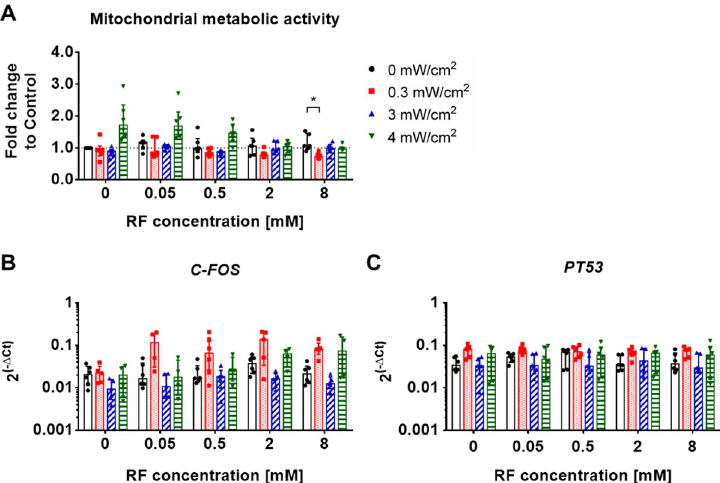
Fig 5. Viability analysis of AF cells directly after Riboflavin (RF) and UVA light treatment. A) Mitochondrial metabolic activity normalized to the DNA amount and the untreated control group (DMEM alone; control = 1, dashed line). B) mRNA expression of bovine C-FOS and PT53 normalized to GAPDH housekeeping gene. Results are presented as median ± IQR (n = 4–6; 2 biological replicates and 2–3 experimental replicates). Kruskal-Wallis test was used for statistical analysis, � P <